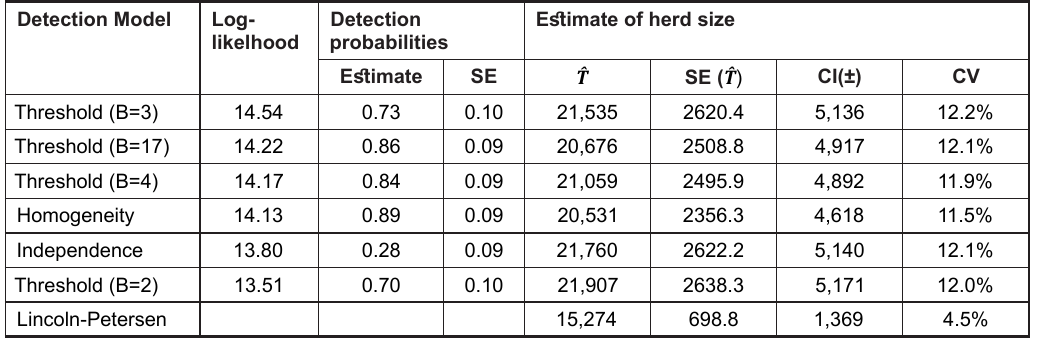
Table 20. Model selection and herd size estimates for the Bluenose-West 2015 post-calving survey. Detection